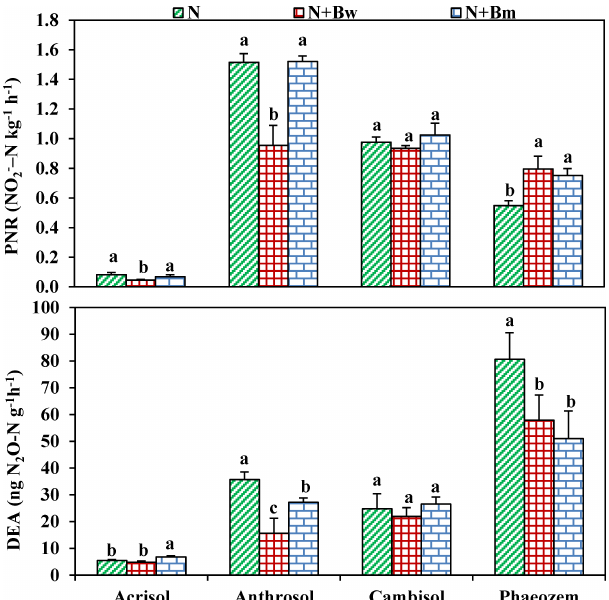
Figure 1. Potential nitrification rate (PNR) and denitrification en- zyme activity (DEA) under different treatments in Acrisol, An- throsol, Cambisol and Phaeozem. The three treatments with each soil were urea without biochar ( N ), urea with wheat straw biochar ( N + B w ) and urea with swine manure biochar ( N + B m ). Bars indi- cate standard deviation (mean + SD, n = 3). Different letters above the bars indicate significant differences among the different treat- ments within the same soil, at p< 0 .